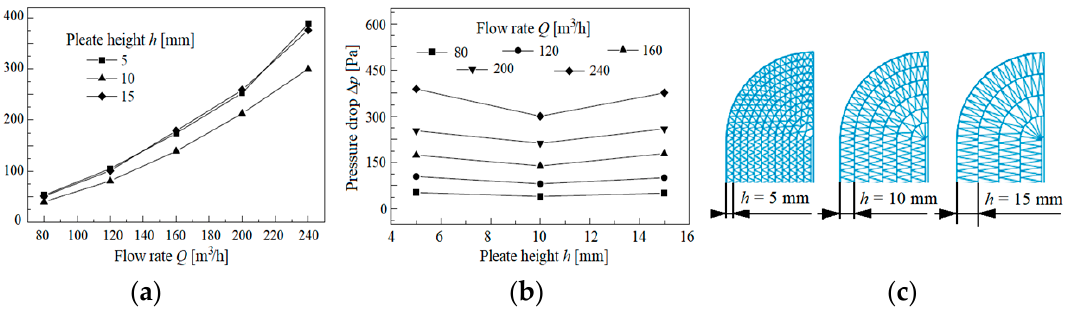
Figure 10. Change in pressure drop as a function of: ( a ) flow rate at different pleat heights, ( b ) pleat heights at different flow rates, ( c ) filter bed structure. Figure made by the author based on data from [61].